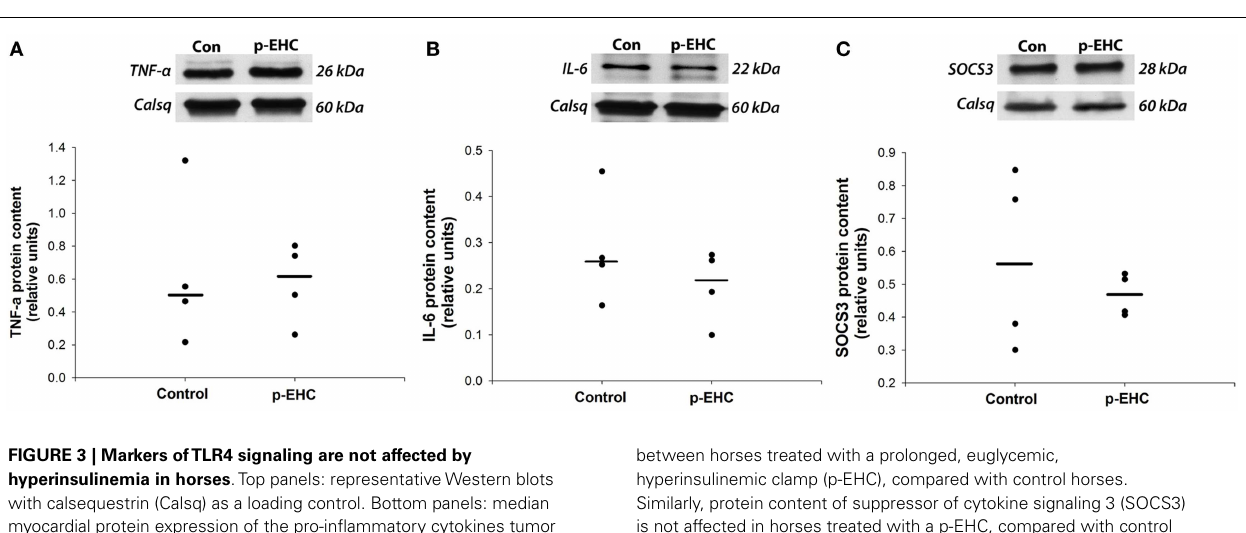
between horses treated with a prolonged, euglycemic, hyperinsulinemic clamp (p-EHC), compared with control horses. Similarly, protein content of suppressor of cytokine signaling 3 (SOCS3) is not affected in horses treated with a p-EHC, compared with control horses (C)